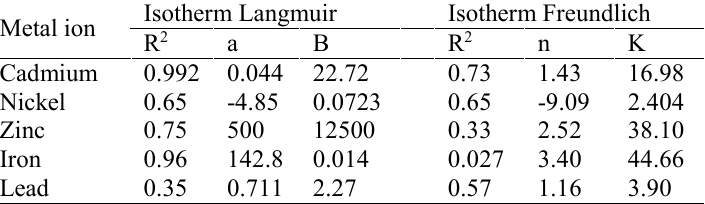
Table 2. Results of fitting freundlich and langmuir models for